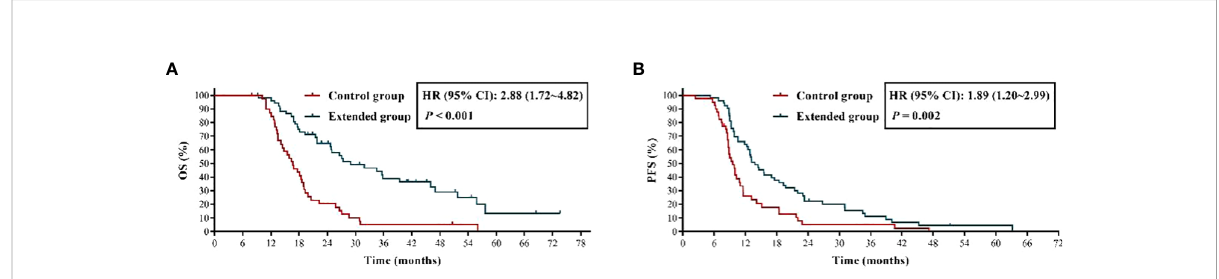
FIGURE 2 The effects of extended adjuvant temozolomide chemotherapy on the clinical outcomes of patients with newly diagnosed glioblastoma. (A) The Kaplan − Meier survival curves for overall survival. (B) The Kaplan − Meier survival curves for progression-free survival.